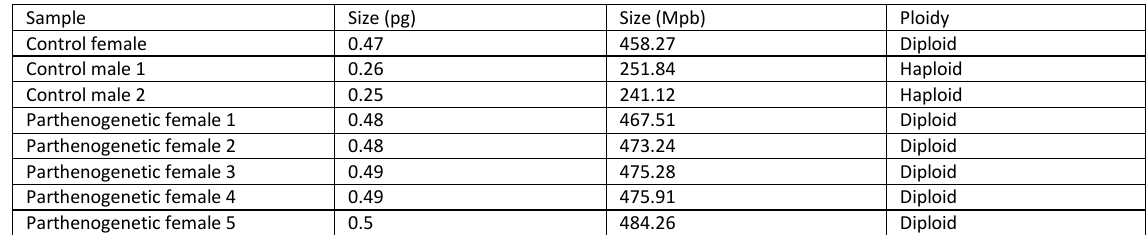
Table 2: Genome size estimated by flow cytometry.